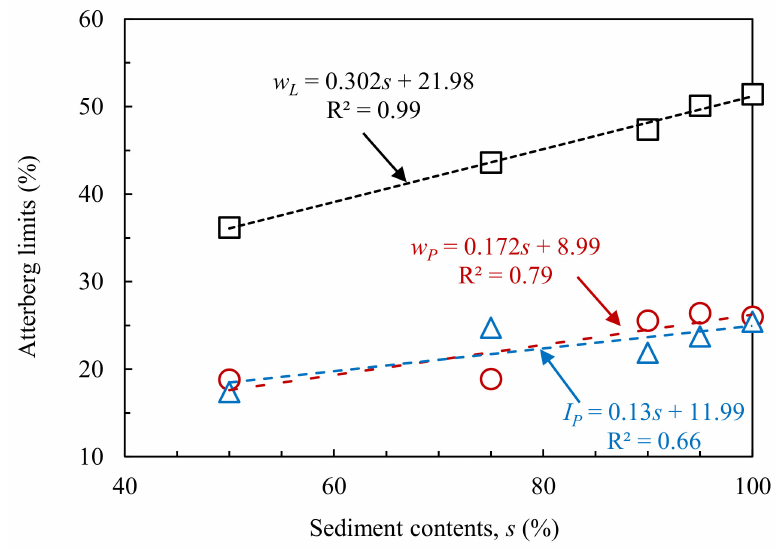
Figure 6. Relationship between Atterberg limits and sediment